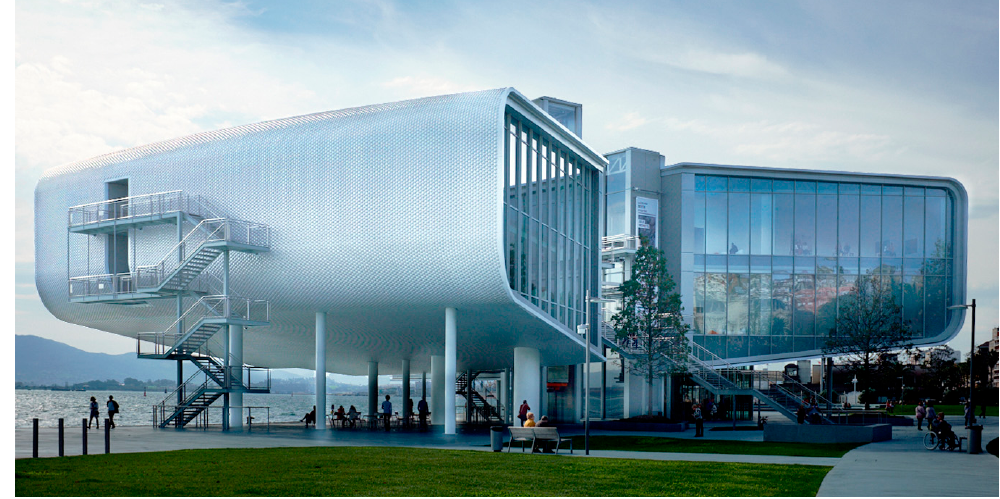
Figure 1. View of the Botín Foundation headquarters in Santander. Photograph: Ángel de los Ríos. https://support.google.com/legal/answer/3463239?sa=X&ved=2ahUKEwir__2px4ngAhUuz4UKHSn ND9AQlZ0DegQIARAB. Luminosity and lightness, one of its essential design features, stand out. The construction is supported by pillars and columns forming a cantilever over the Bay of Santander and the old Albareda and Maura docks. The building also respects the height of the Pereda Gardens treetops. Light is reflected in the ceramic façade, composed of 280,000 discoidal and pearl tiles, adapted to the building’s geometry, with an iridescent effect applied to the finishing